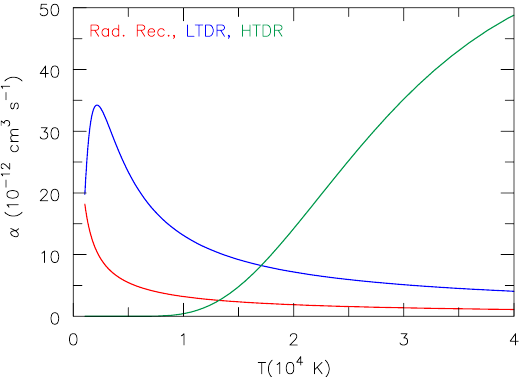
Figure 5. Comparison of the recombination coefficients for normal radiative recombination, for LTDR and for HTDR for recombination from C 3 + to C 2 + . Only at low temperatures ( (cid:46) 1000K) does radiative recombination dominate. Above this temperature LTDR dominates until a temperature of ∼ 17,000K, at which time HTDR becomes the dominant recombination